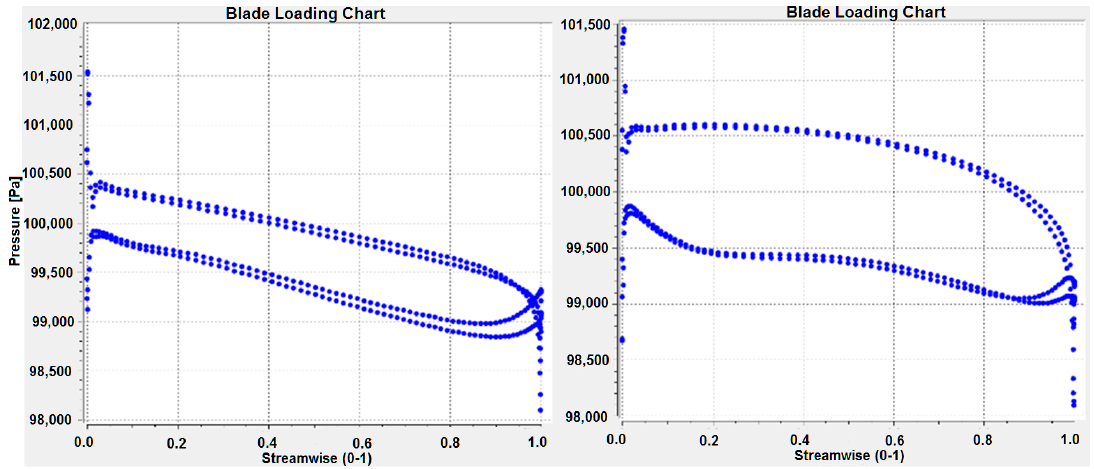
z , right: z = 0.54 z ORG ORG